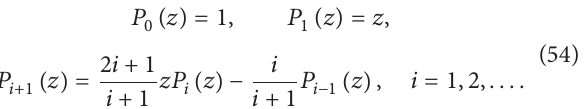
Figure 1: The shifted Legendre functions for different 𝑚